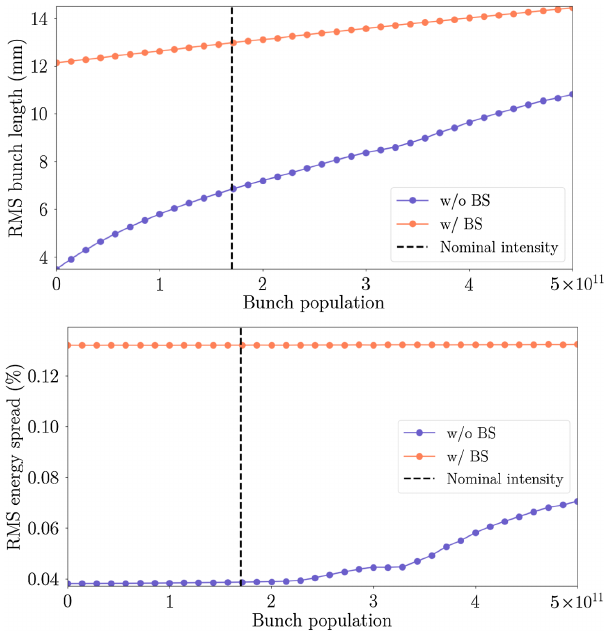
FIG. 20. RMS bunch length (top) and RMS energy spread (bottom) as a function of the bunch population with (orange curve) and without (blue curve) beamstrahlung (BS), given by numerical simulations by considering the impedance contribution of all the machine